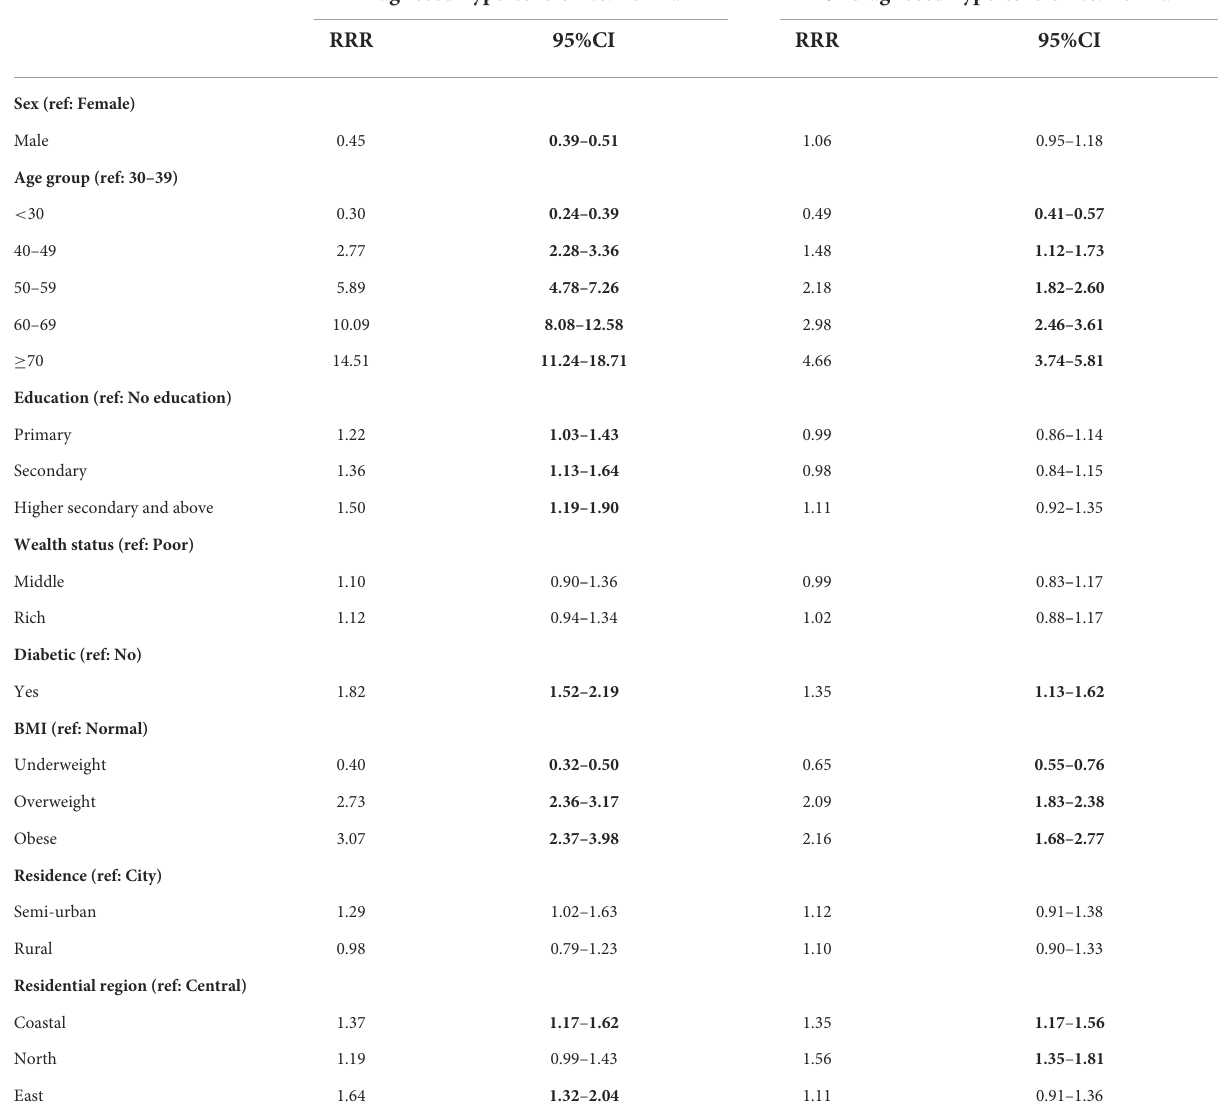
TABLE 2 Associated factors of diagnosed hypertension and undiagnosed hypertension identified using multivariable multinomial regression models. Diagnosed hypertension vs. normal Undiagnosed hypertension vs.